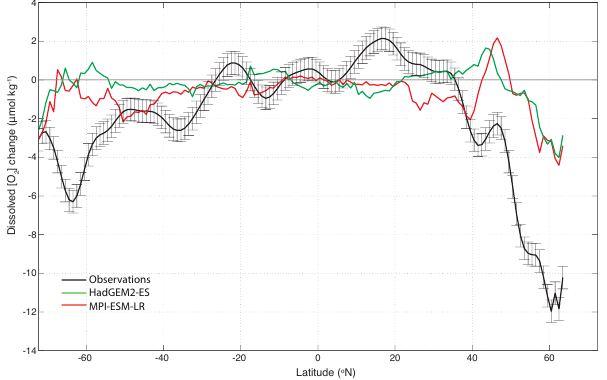
Fig. 3. Zonal mean change (~1992 minus ~1970) in [O 2 ] (µmol kg -1 ) as a function of latitude averaged between 100 and 3000 metres depth for observations (black; Helm et al. [2011]), and HadGEM2-ES (green) and MPI-ESM-LR (red) historical integrations. Error bars in observed [O 2 ] are given at the 95 % confidence level and are associated with instrumental uncertainty, un-resolved ocean processes and methodological uncertainty in forming the zonal averages (derived from an a priori estimate of noise using the method of Bindoff and Wunsch [1992]).